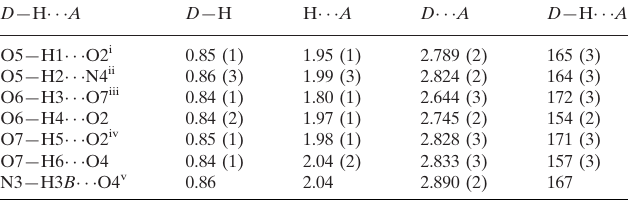
Hydrogen-bond geometry (A˚ , (cid:3)